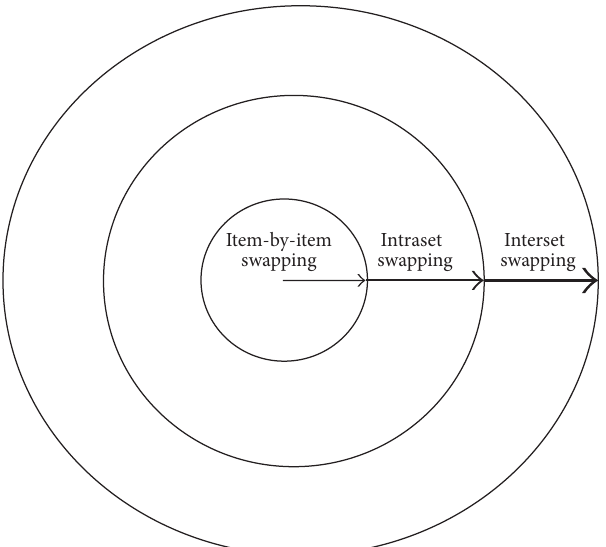
Figure 3: A schematic representation of the neighborhood expanding data-interchanging heuristic. As the neighborhood expands, the probability of finding pairable swaps increases (indicated by the thickness of the arrow).